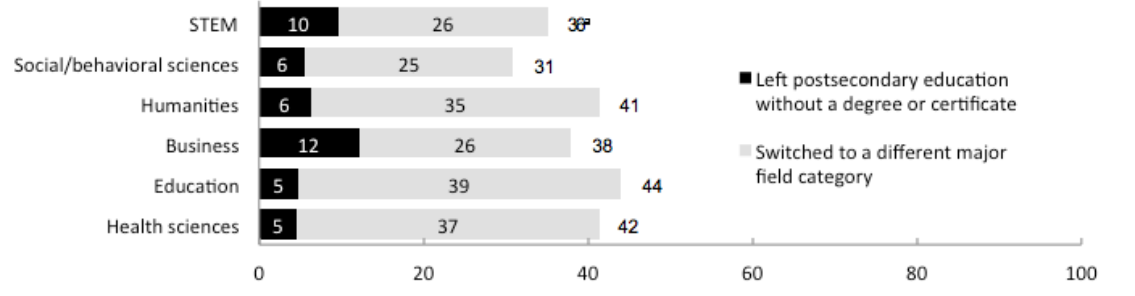
Figure 4. Atriton rates in STEM and selected non-STEM felds among high-performing students